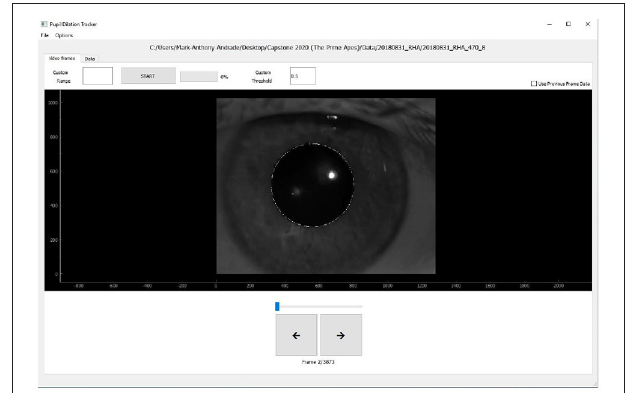
FIGURE 1 | User interface for the developed pupil tracking system.